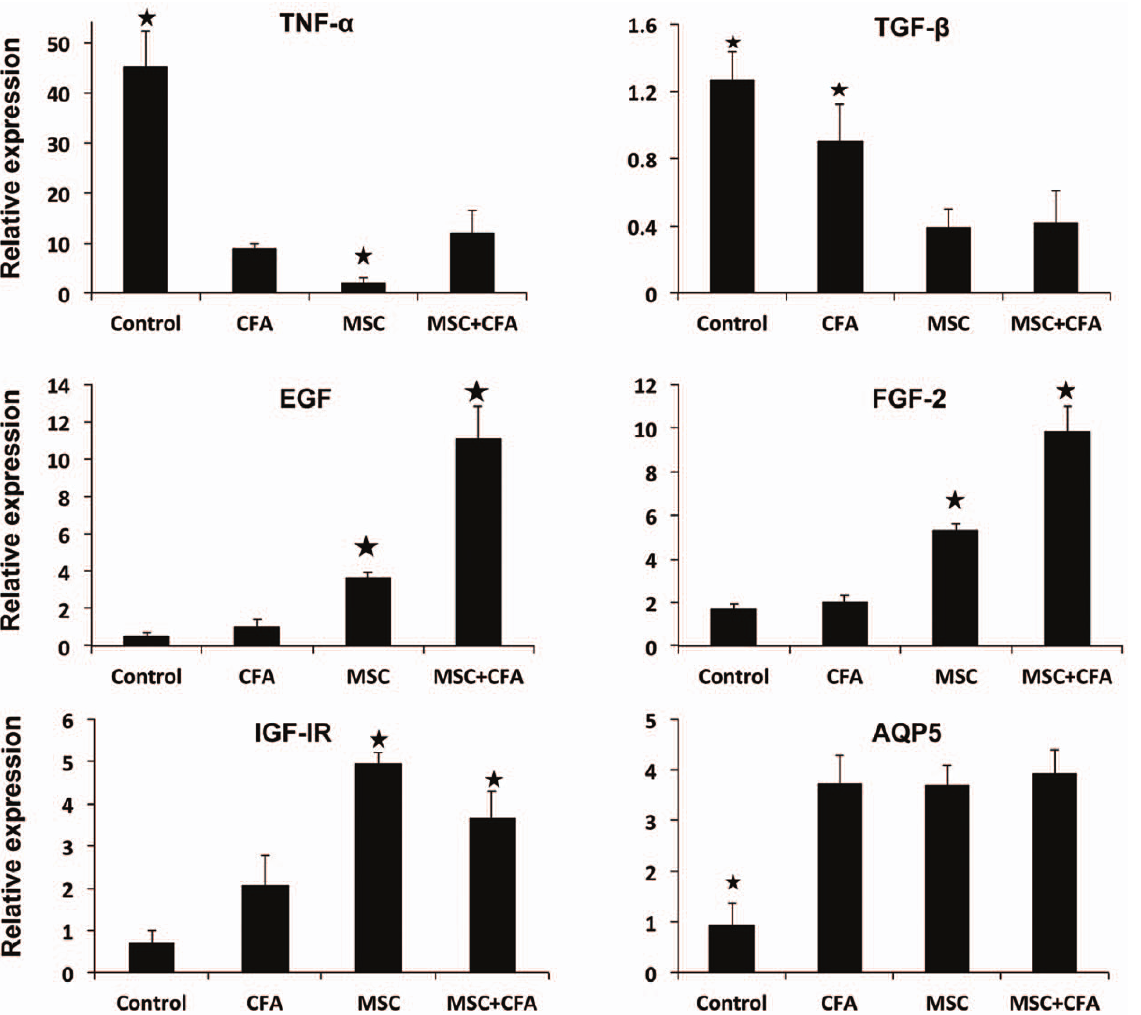
Figure 3. Relative gene expression of key inflammatory cytokines and growth factors involved in the pathogenesis of Sjo¨gren’s syndrome. TNF- a and TGF- b mRNAs were downregulated in CFA-treated and MSC + CFA versus control NOD mice (upper panel; * P , 0.05). NOD mice transplanted with only MSCs had the lowest expression of TNF- a (* P , 0.05). EGF, IGF-IR and FGF-2 mRNAs (middle and lower panels) were upregulated (* P , 0.05) in MSC and MSC + CFA groups. The combined therapy (MSC + CFA) had the highest upregulation for regenerative genes (EGF, FGF-2). n=4 to 8 mice per group.